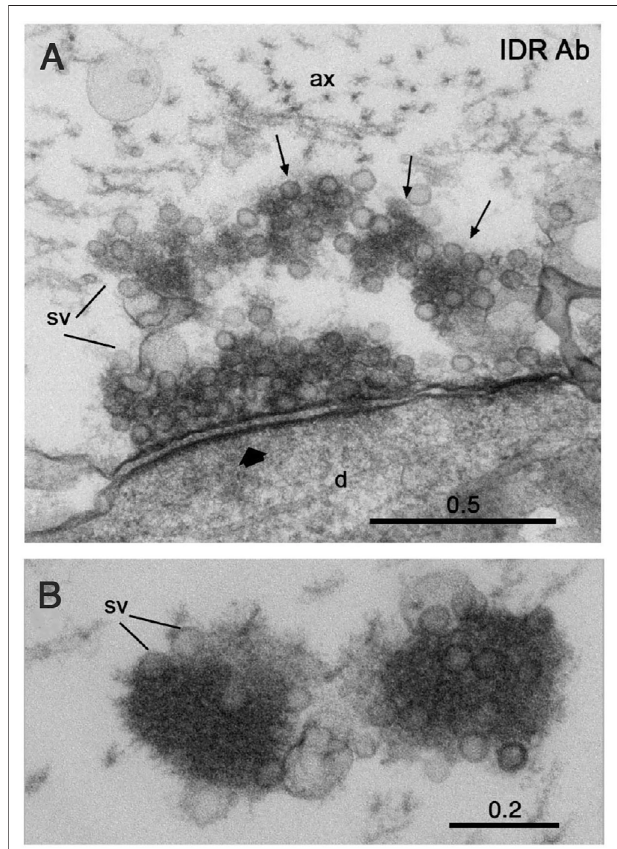
FIGURE 4 | Disruption of the SV liquid phase by antibodies to the IDR of synapsin results in formation of electron-dense protein aggregates in the lamprey giant synapse. (A) Electron microscopic image showing partial disruption of the vesicle cluster and formation of electron dense condensates associated with synaptic vesicles (arrows) in a synapse in a reticulospinal axon at rest. (B) Electron dense condensates associated with synaptic vesicles (sv) in a synaptic region of a resting axon microinjected with antibodies at higher magni fi cation. Scale bars in µm. From (Pechstein et al.,